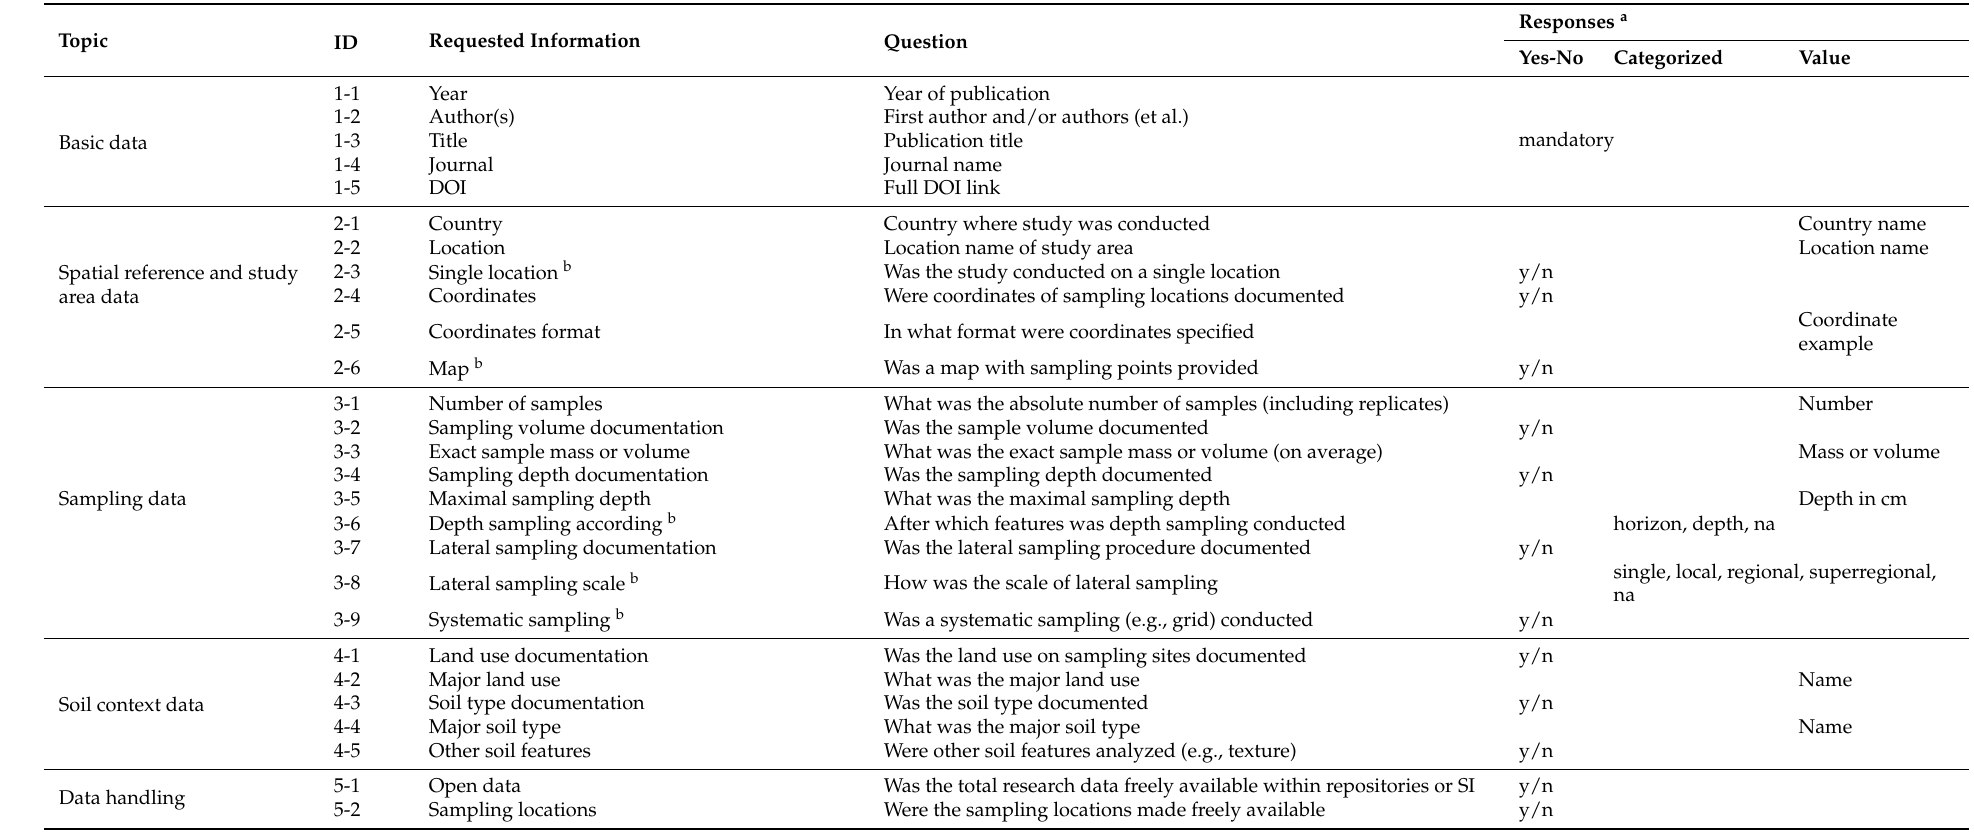
Table 1. Questionnaire applied to each study and possible responses. Full dataset available: https://doi.org/10.6084/m9.figshare.20059022, accessed on 14 July